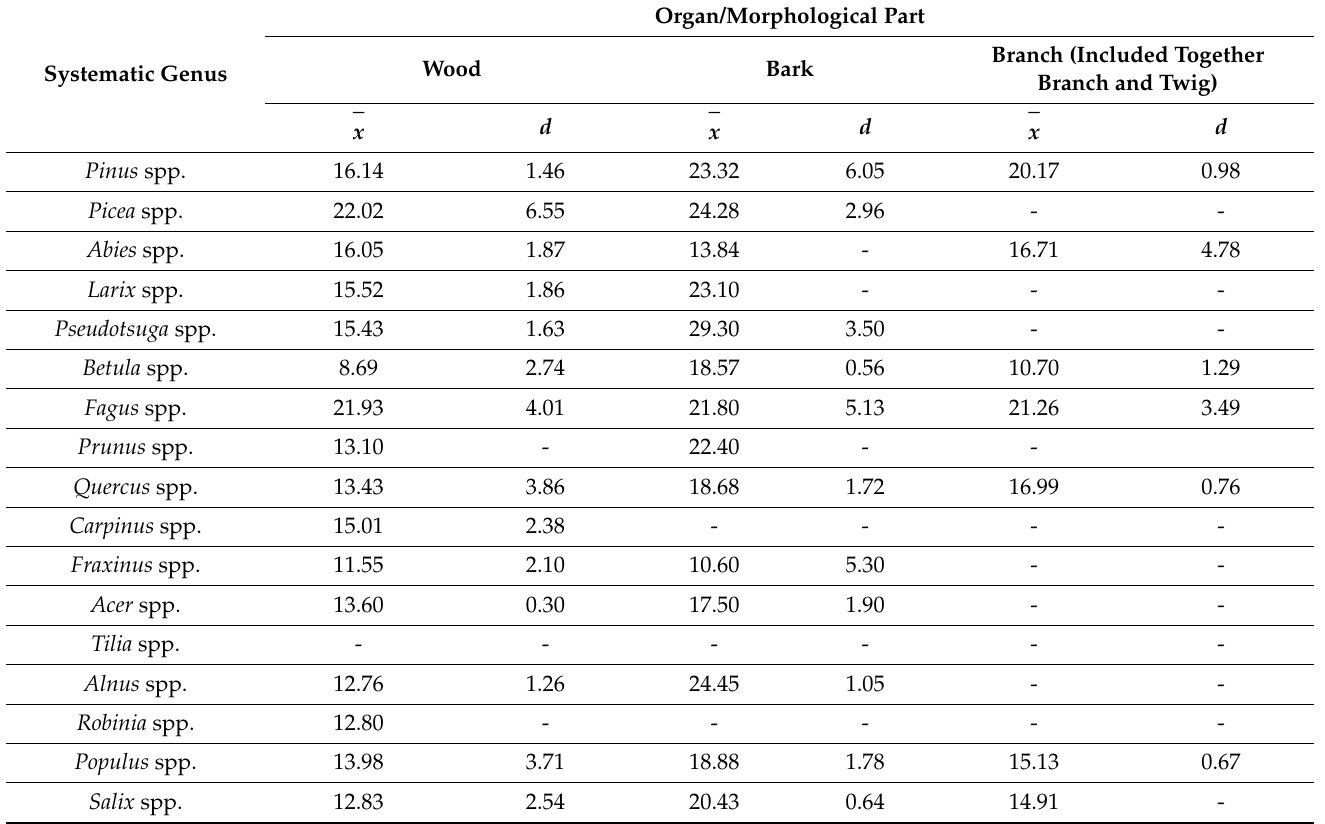
Table A15. Average value and average deviation of the fixed carbon content (% d.m.) in various organs of particular systematic genera trees.